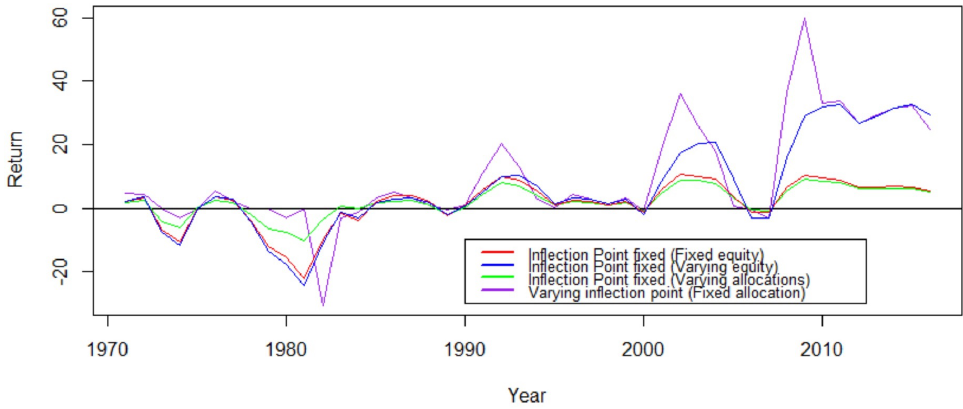
Figure 12. Return on changing leverage levels κ -red, ζ -blue, and ν -green vs. year in